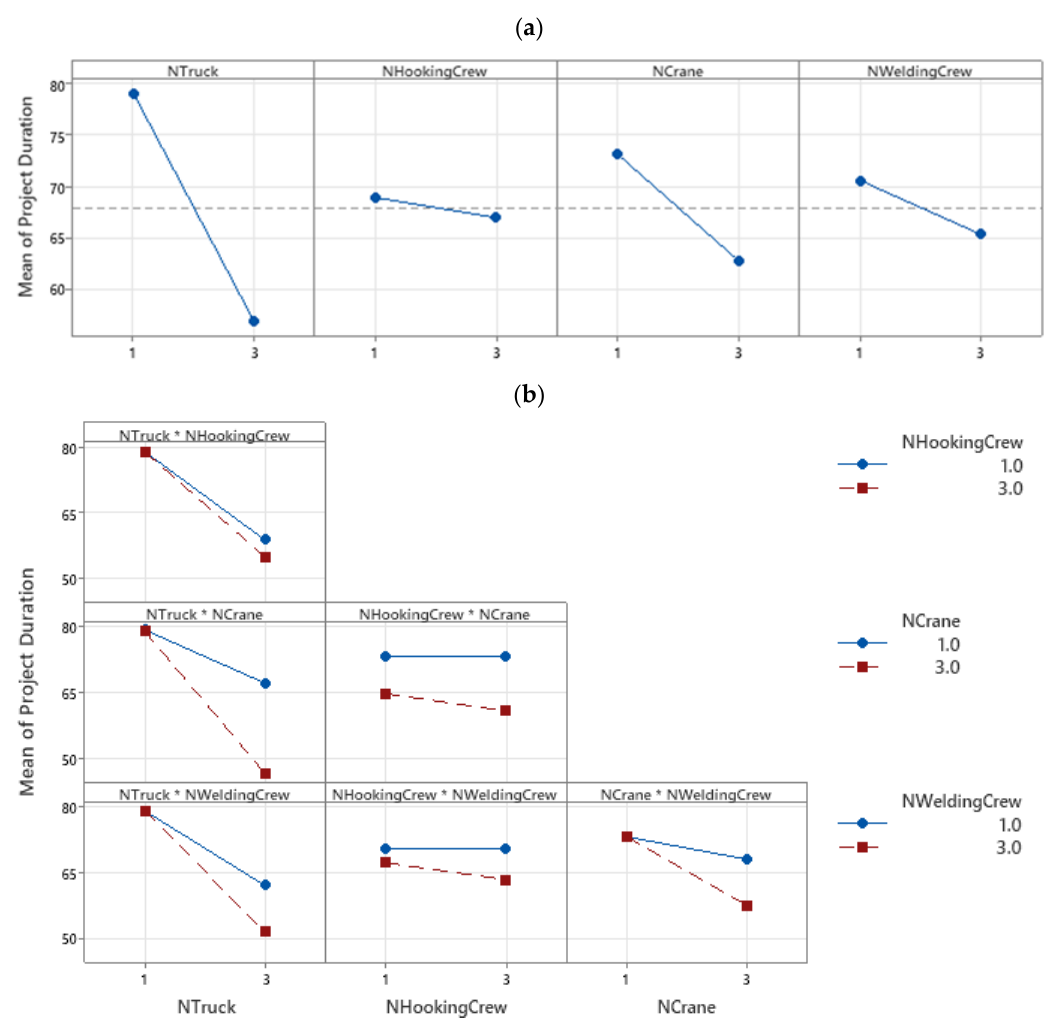
Figure 6. Significant parameters and their interactions on project duration. ( a ) Main effects plot for project duration; ( b ) interaction plot for project duration.